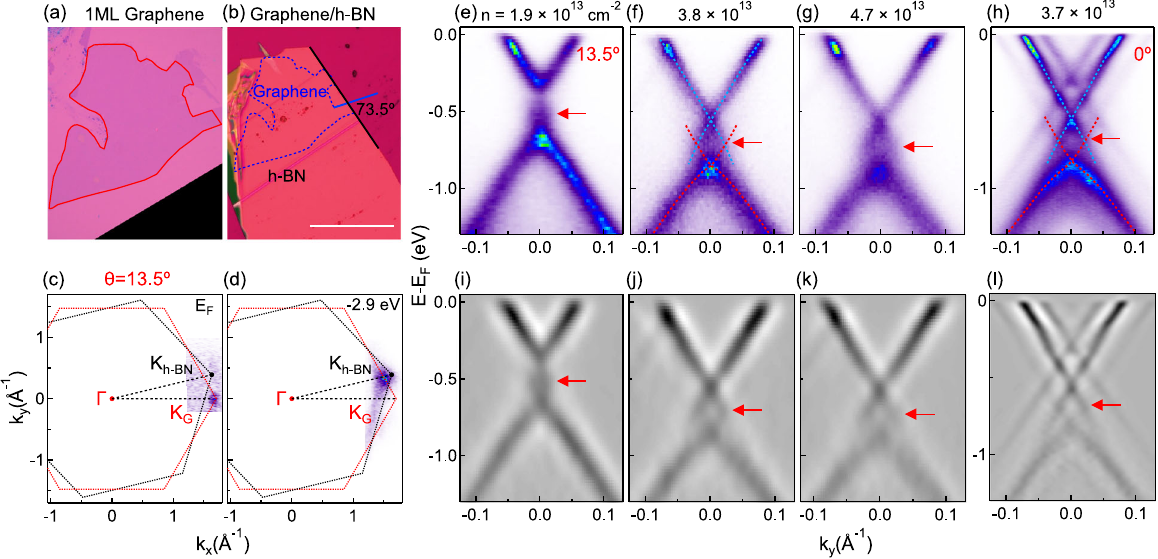
Fig. 3 Plasmaron dispersion observed in a 13.5° twisted graphene/h-BN heterostructure. a , b Optical images of exfoliated monolayer graphene and graphene/h-BN heterostructure. The twist angle determined from the straight edge is 73.5° (equivalent to 13.5°). Scale bar indicates 100 μ m. c , d Energy contours at Fermi energy and − 2.9 eV to reveal the K points of graphene and h-BN, which con fi rm the twist angle of 13.5°. e – g Dispersion of 13. 5° graphene/h-BN at different carrier density to show the evolution of plasmaron bands upon doping. h Dispersion of 0° graphene/h-BN at doping level of 3.7 × 10 13 cm − 2 (also shown in Fig. 2g) to compare with results on 13.5° graphene/h-BN sample. i – l 2D curvature results of e – h , which clearly show the diamond-shaped dispersion (indicated by red arrows) formed by the Dirac cone and plasmaron